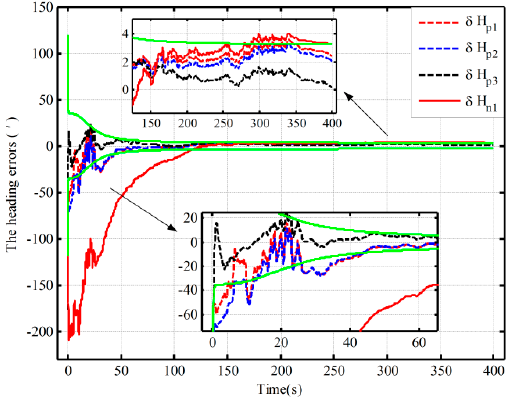
Figure 11. The alignment experiments based on the closed-loop KF.